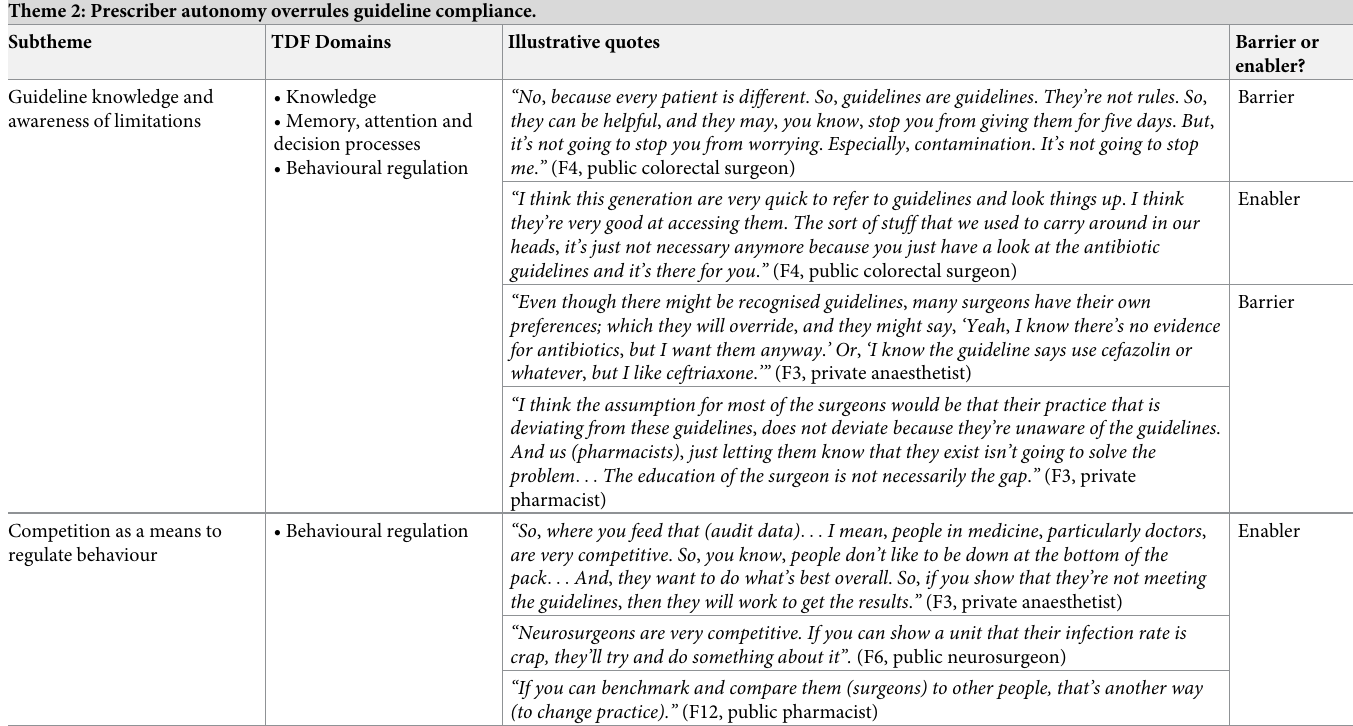
Table 3. Representative quotations from Theme 2 reflecting ‘Psychological Capability’ of the COM-B model. Theme 2: Prescriber autonomy overrules guideline